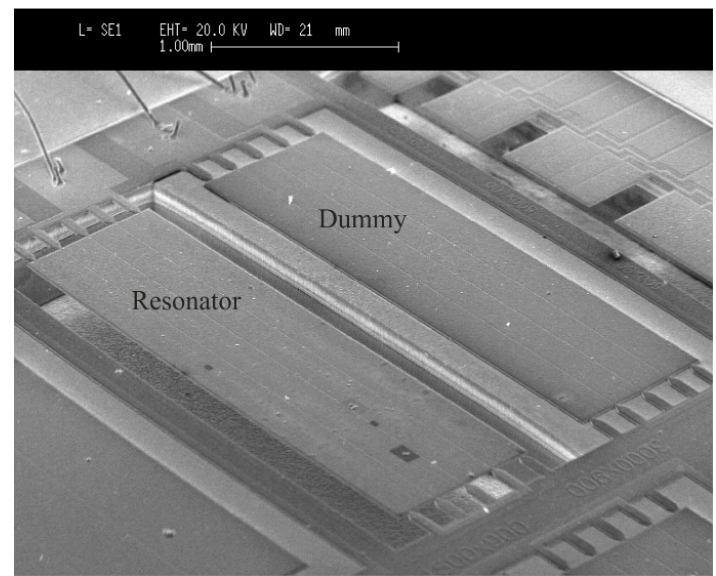
Figure 11. Micrograph of the 05-mode resonator and the dummy device with scanning electron microscope (SEM) after the deposition of cigarette particles.